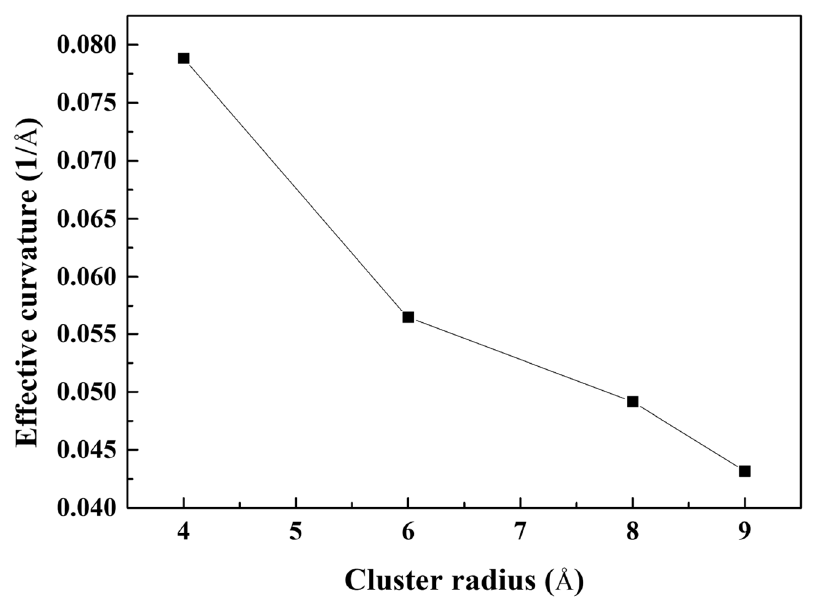
Figure 9. Effective curvature of the cracked Al containing Mg–Si clusters as a function of the cluster radius.